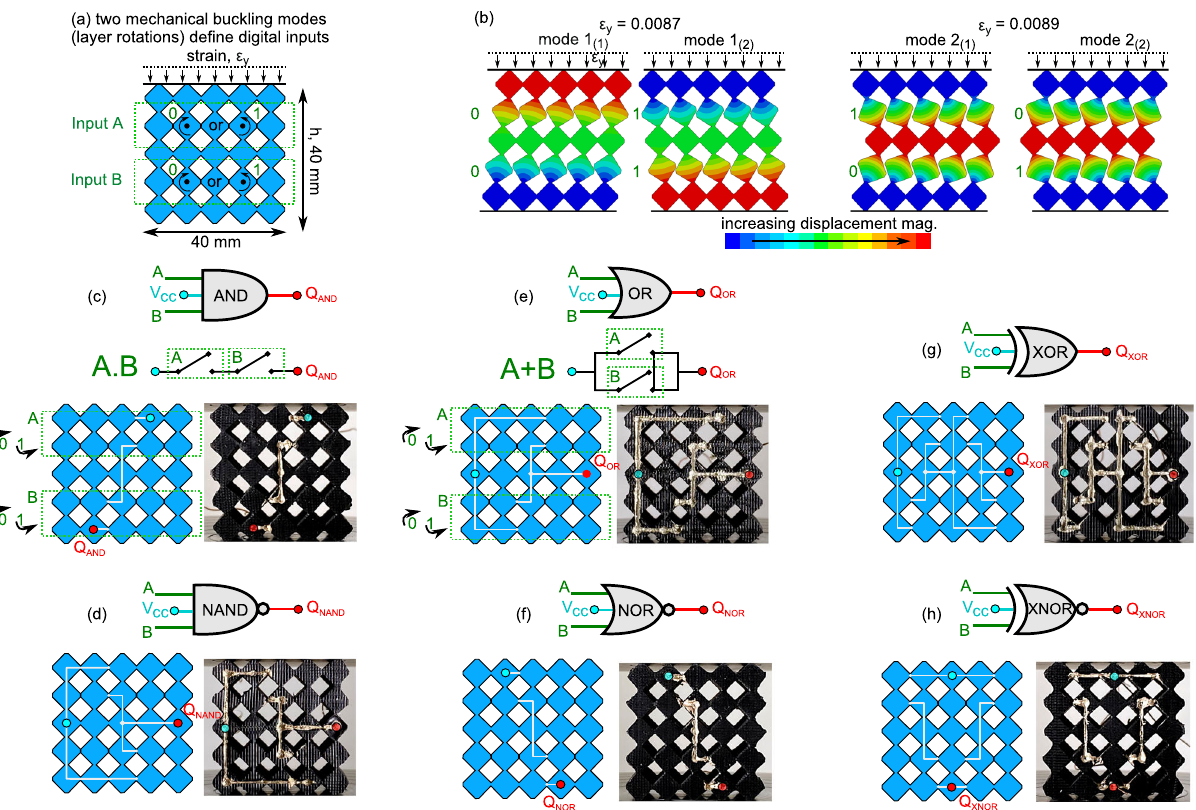
Fig. 4 Formulation of digital logic gates in soft, conductive mechanical metamaterials. a Schematic of the D 1 based metamaterials. Inputs A and B are the rotations in the fi rst and second layers, respectively. b Modal analysis illustrating four possible deformation states. Schematics and experimental images of the Ag-TPU network on the metamaterials for ( c ) AND, ( d ) NAND, ( e ) OR, ( f ) NOR, ( g ) XOR, and ( h ) XNOR logic gates. AND and OR include corresponding switched circuit schematics. Each gate contains two mechanical inputs A and B (green) and one digital output Q (red). The powered input terminal is the cyan node, V cc